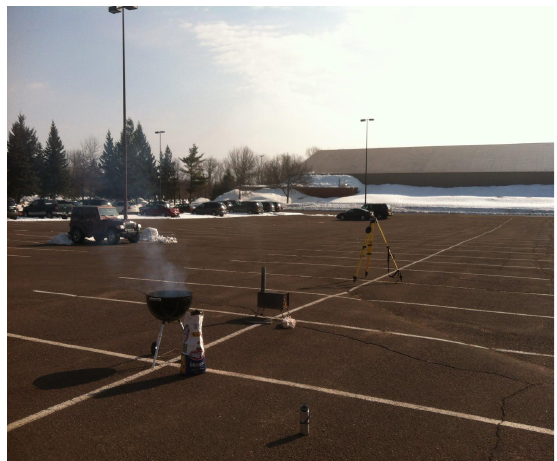
Figure 4. Experimental heat sources for testing UAV